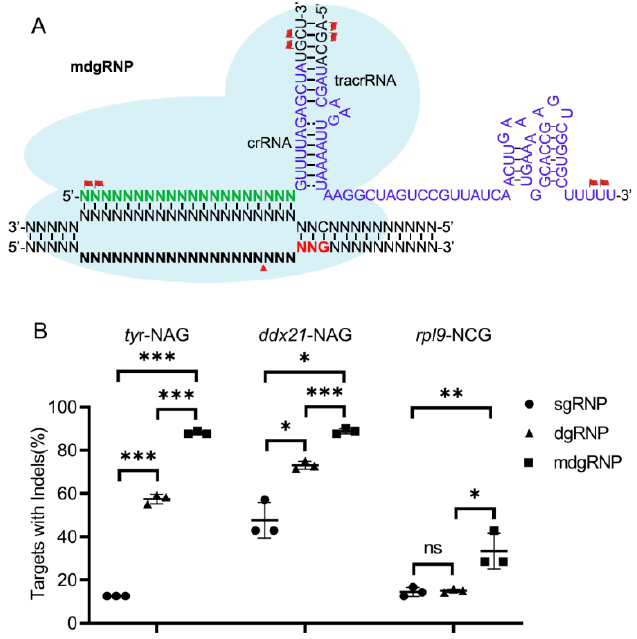
Figure 3. Chemically modified crRNA and tracrRNA duplex increased the ScCas9 efficiency. ( A ), Schematic illustration of the ScCas9 mdgRNP complex. The crRNA and tracrRNA scaffold with MS modified nucleotides (flag) at both termini coupled with the ScCas9 protein were loaded to the chromosome. ( B ), Statistics of gene editing efficiency induced by sgRNP, dgRNP and mdgRNP. ns, no significant difference; * p value < 0.05; ** p value < 0.01; *** p value < 0.001.